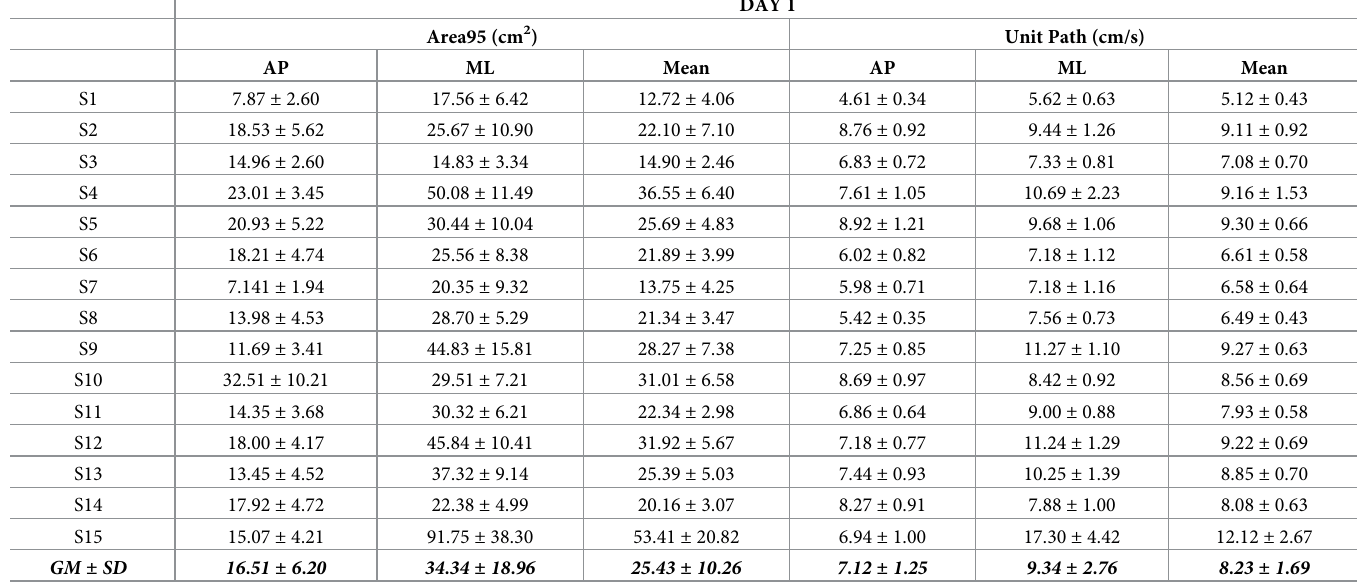
Table 1. Mean values, group means (GM), and standard deviations (SDs) of the CoP-related parameters (Area95 and Unit Path) during the unstable board test (DAY1)